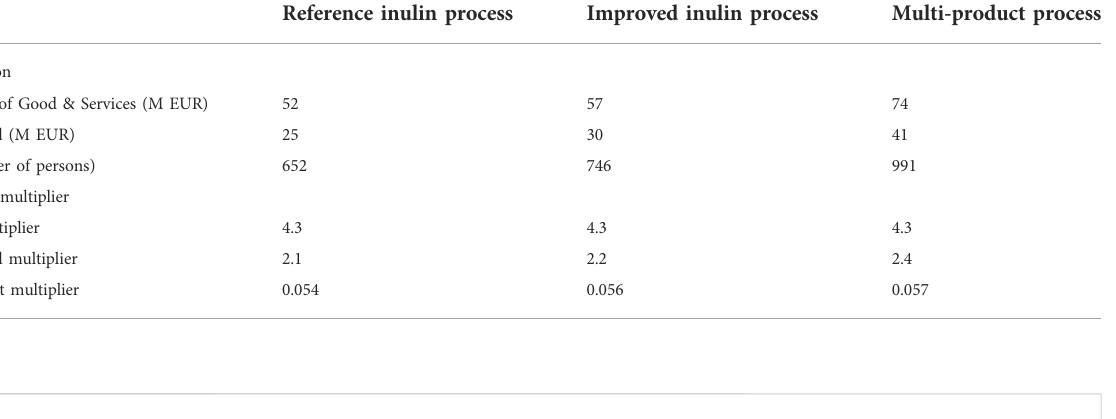
TABLE 3 Socio-economic effects of each scenario.